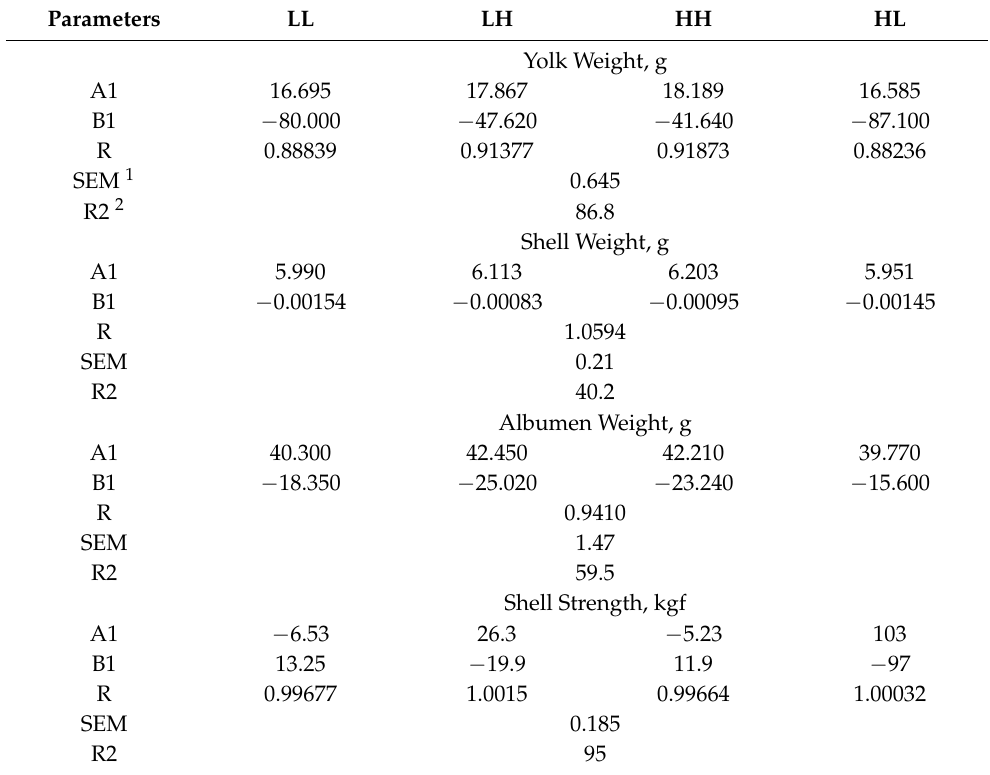
Table 8. Coefficients of exponential equation for egg response of laying hens from 19 to 102 weeks old consuming levels of dietary balanced protein (LL or HH), repleted (LH) and depleted feeds (HL).